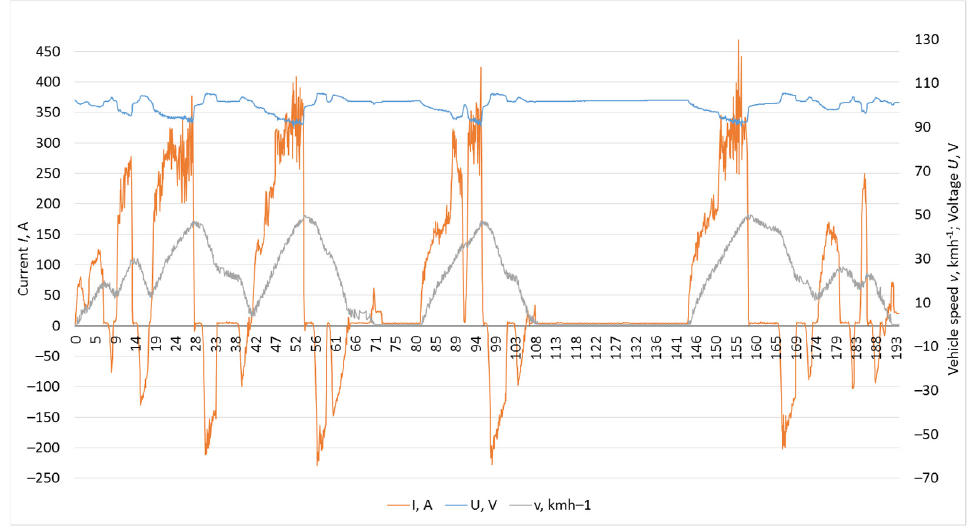
Figure 4. Example of road test data recorded when driving in 2nd gear at an 100% regenerative braking setting.